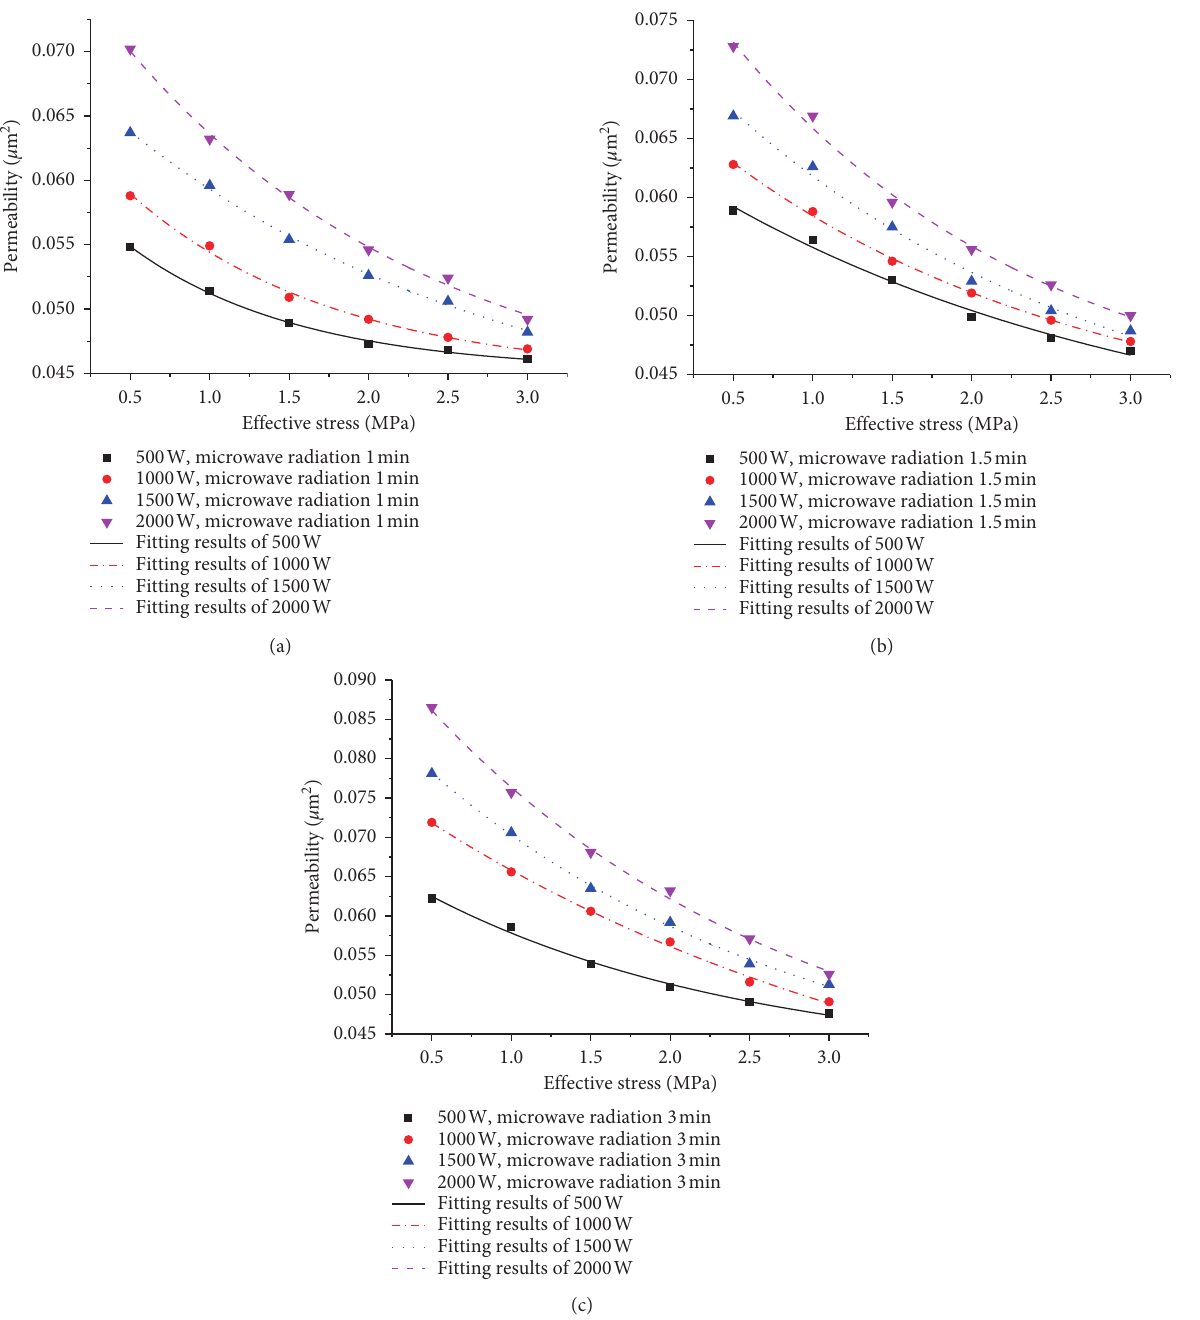
Figure 7: Effect of microwave power on the permeability at a confining pressure of